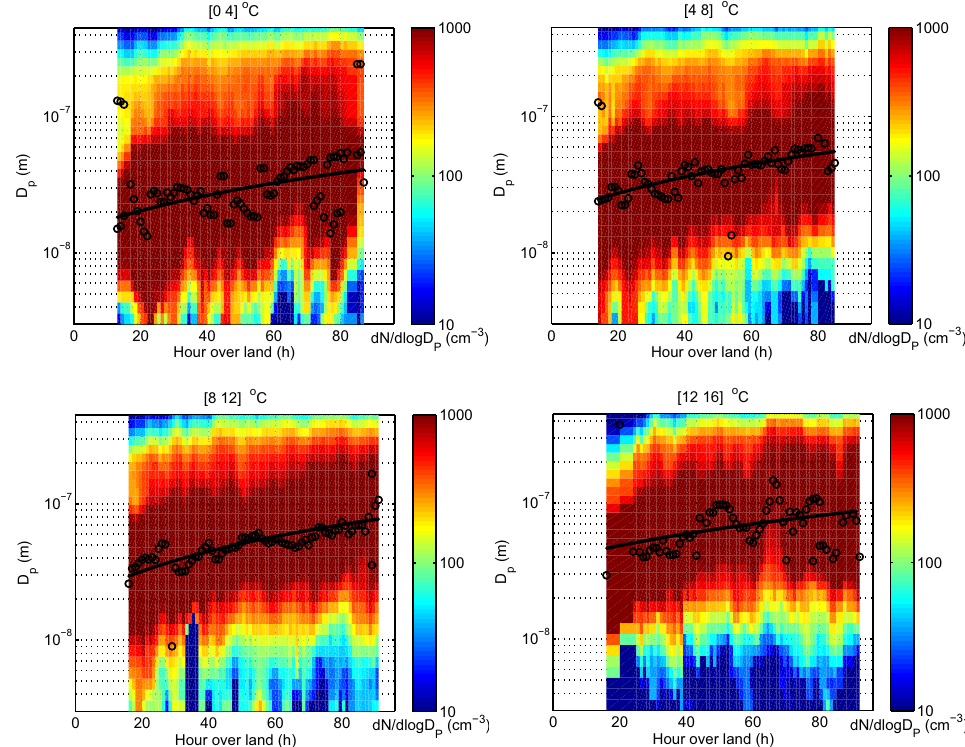
Figure 4. Aerosol particle-size distributions as a function of hour over land in the first four temperature bins at the SMEAR II station, Hyytiälä. The black circles are the maxima of the normal size distribution function at each hour, and black line depicts the mode